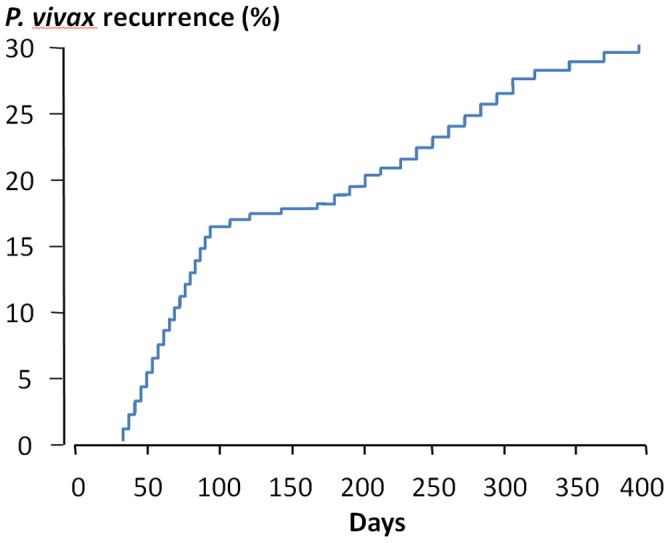
The temporal pattern of the 47 recurrences of Plasmodium vivax malaria in 151 patients with acute vivax malaria in Kolkata following treatment with chloroquine +/− primaquine.The three treatment groups were pooled as there were no significant differences in recurrence proportions between them.